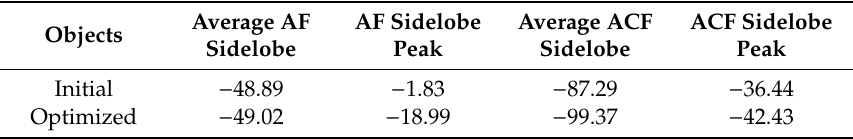
Table 1. The sidelobe levels of LFM-Costas pulse train (dB).